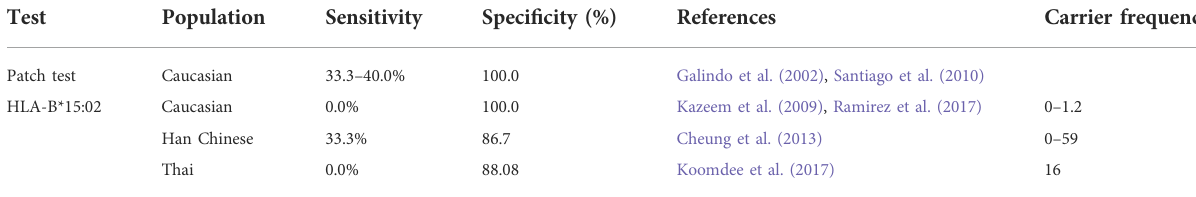
TABLE 8 Sensitivity and speci fi city of patch tests and HLA tests for lamotrigine-induced DRESS. Test